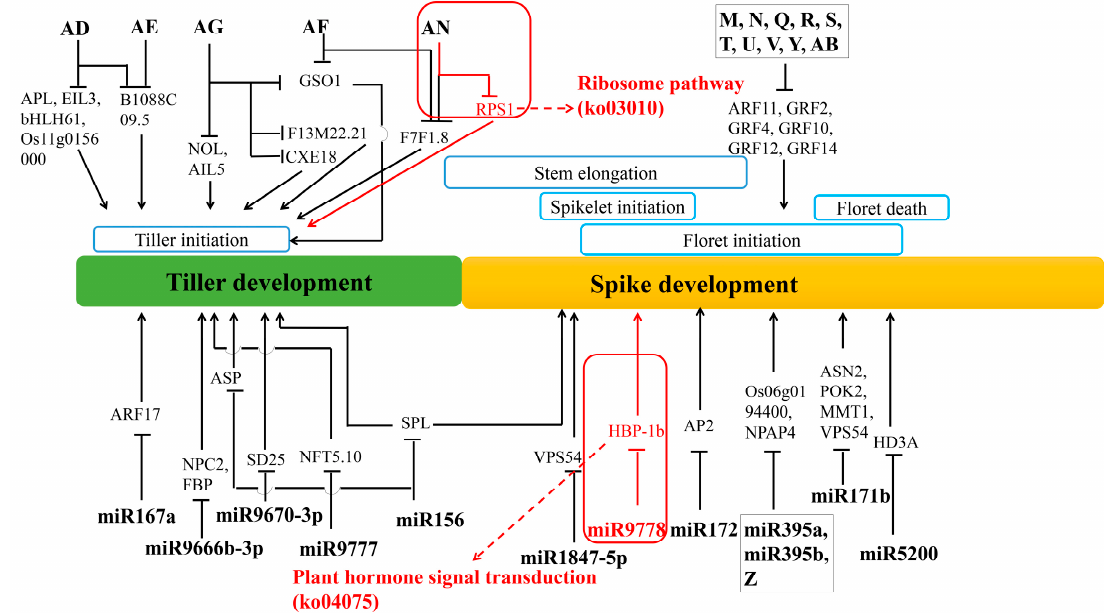
Figure 10. A model of the wheat tillering and spike di ff erentiating related key miRNA–mRNA regulation network. The red rectangles indicate the miRNA and targets involved in the two most significant metabolic pathways in tiller primordia and young spikes (Table 1). For short the “tae-” before the known miRNAs is omitted. Words A-AN represented di ff erent novel miRNAs, the original ID corresponding to these new miRNAs were listed in Table S17.